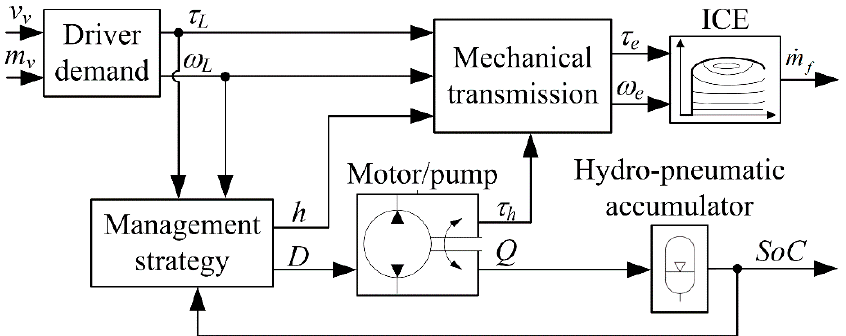
Figure 5. Block diagram of quasi-static model of hydraulic hybrid driveline in parallel configuration.